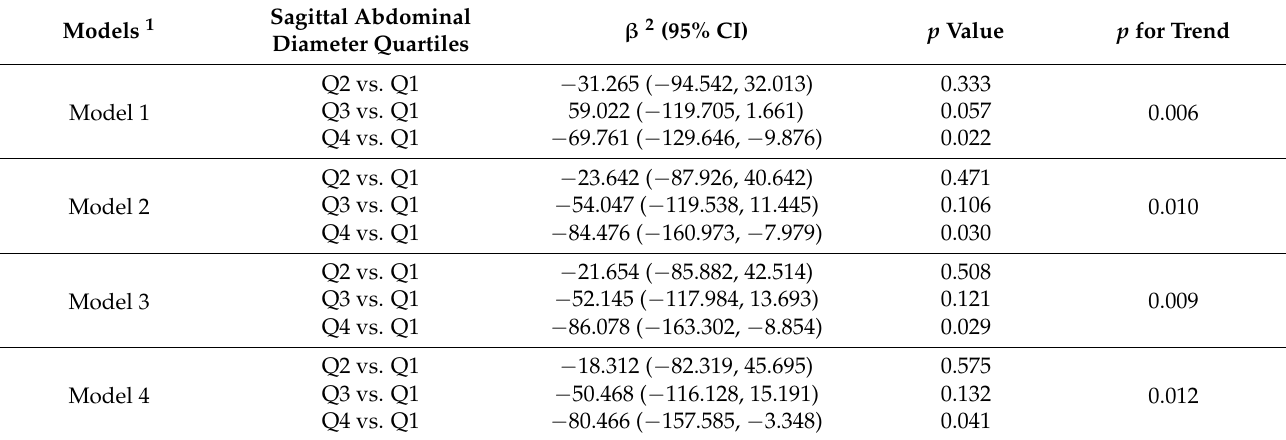
Table 5. Association between the sagittal abdominal diameter comparison and serum Klotho